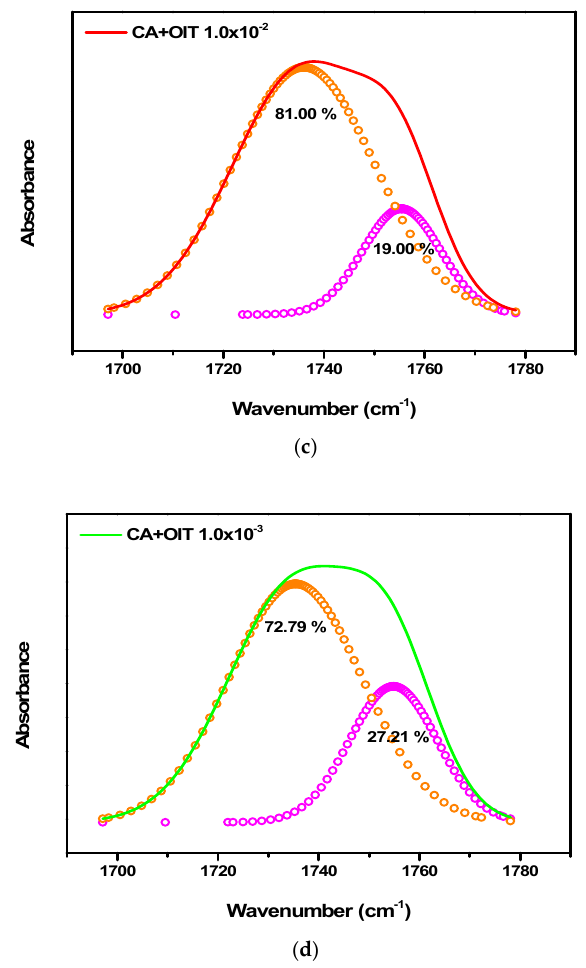
Figure 6. Deconvolution spectra of ( a ) neat CA, ( b ) 1:1.0 × 10 − 1 CA/OIT, ( c ) 1:10 × 10 − 2 CA/OIT and ( d ) Figure 5. Deconvolution spectra of ( a ) neat CA, ( b ) 1:1.0 × 10 − 1 CA / OIT, ( c ) 1:10 × 10 − 2 CA / OIT and ( d ) 1:10 × 10 − 3 CA/OIT. 1:10 × 10 − 3 CA / OIT. Table 2. Area ratio of deconvoluted carbonyl peaks at various OIT concentrations. Table 2. Area ratio of deconvoluted carbonyl peaks at various OIT